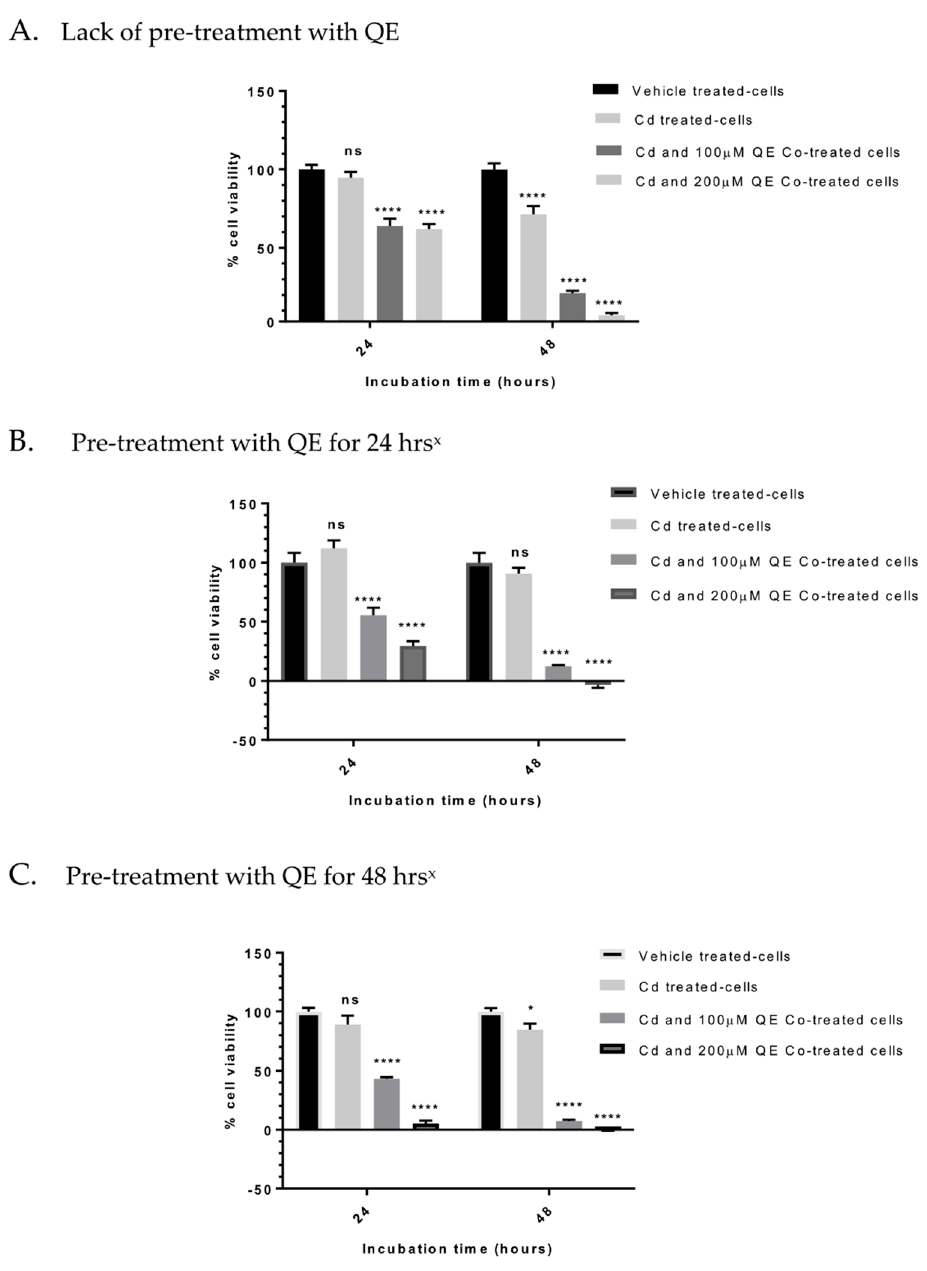
Figure 4. The anti-proliferative effect of the co-treatment of 1321N1 cells with QE and Cd. Cells seeding density at the start of the experiments was 2 × 10 4 cell/well. At the end of treatment conditions stated in ( A – C ), cells cultures were evaluated for their viability by MTT assay and the resulting absorbance values are expressed as percentages with respect to vehicle-treated cells. The bars represent mean ± SEM ( n = 8). * p = 0.0337, and **** p < 0.0001; ns, not significant. x The pre-treatment with QE was used only for cells later co-treated with QE and Cd together.